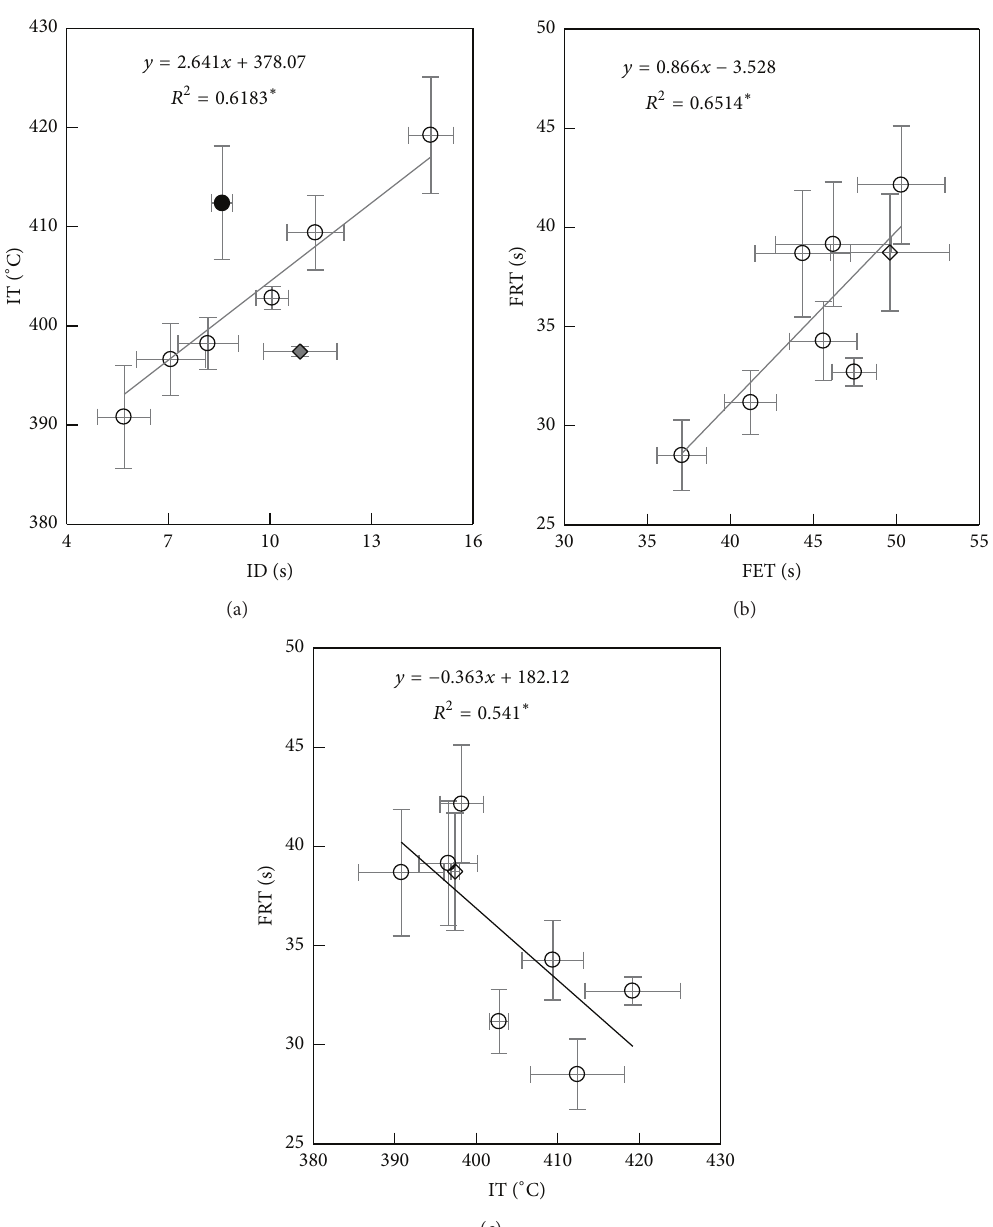
Figure 2: Significant liner regressions between flammability parameters. Points indicate mean values and error bars represent standard error. (a) Linear regression between ignitability related parameters ignition delay (ID) and ignition temperature (IT), with black data point indicating position of L. nobilis and grey data point indicating position of O. europaea . (b) Linear regression between sustainability related parameters flame extinguish time (FET) and flame residence time (FRT). (c) Liner regression between ignitability parameter ignition temperature (IT) and sustainability parameter flame residence time